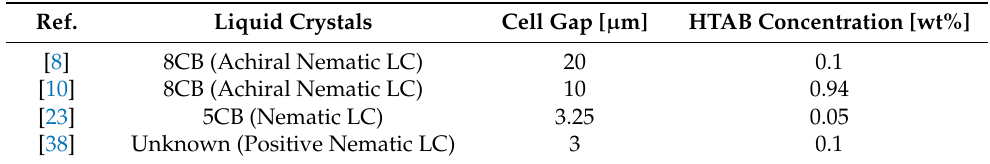
Table 1. The references about the homeotropic alignment using HTAB. Ref.